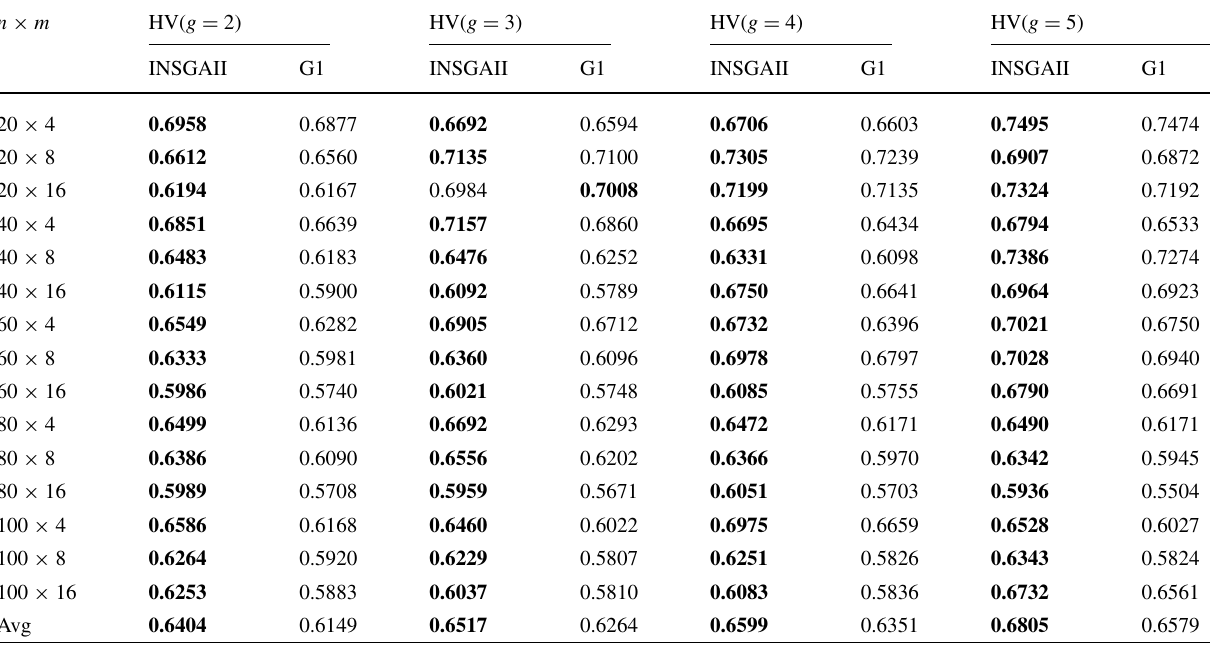
Table 4 Comparisons of the HV values between INSGAII and G1 n × m